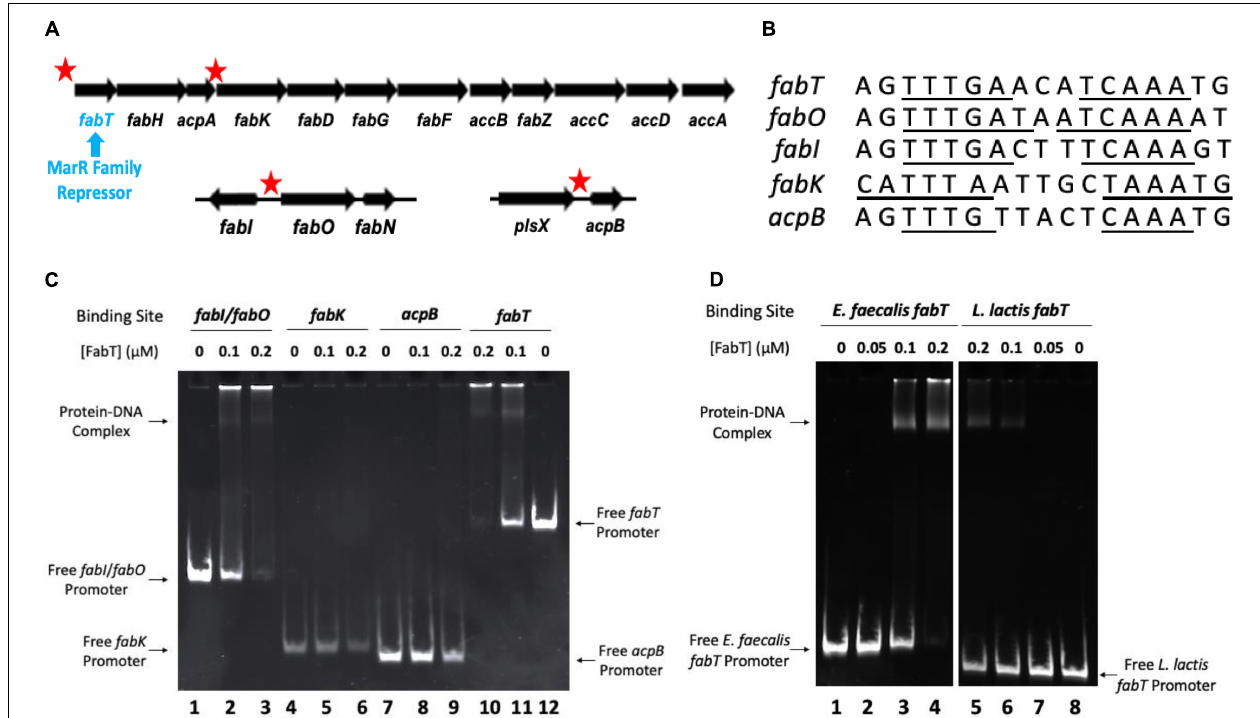
FIGURE 3 | Enterococcus faecalis FabT protein is functional in vitro . (A) Four E. faecalis fab -related DNA gene fragments having putative FabT-binding sites were tested. The sequences tested are indicated by the red stars whereas the fabT gene is referred by the blue arrow. Note that the first fours genes were previously shown to be cotranscribed (Zhu et al., 2019) and a recent report showed that this is the case for the entire eleven gene operon (Hays et al., 2021). (B) The nucleotide sequences of FabT-binding sites of the promoters of fab -related genes above. The underlined sequences indicate the palindromes. (C) EMSA analysis of E. faecalis FabT binding to the fabI / fabO promoter, fabK promoter, acpB promoter, or fabT promoter. (D) EMSA analysis of E. faecalis FabT binding to the E. faecalis fabT promoter (at left) or L. lactis fabT promoter (at right). In panel (D) , both fabT promoters with 0.5 µ M FabT lanes in the middle of E. faecalis group and L. lactis group were deleted since almost all E. faecalis fabT gene promoter fragments were trapped in the well and did not enter the